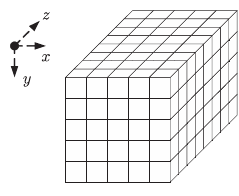
Figure 2: The Keccak- f state.